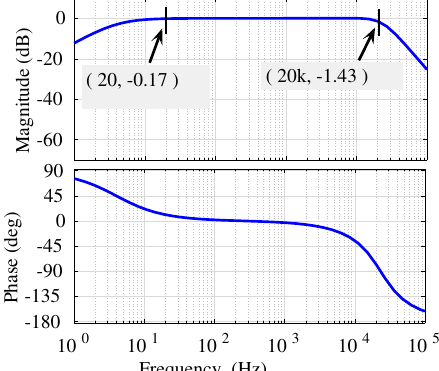
Figure 3. Frequency response of band pass filter.